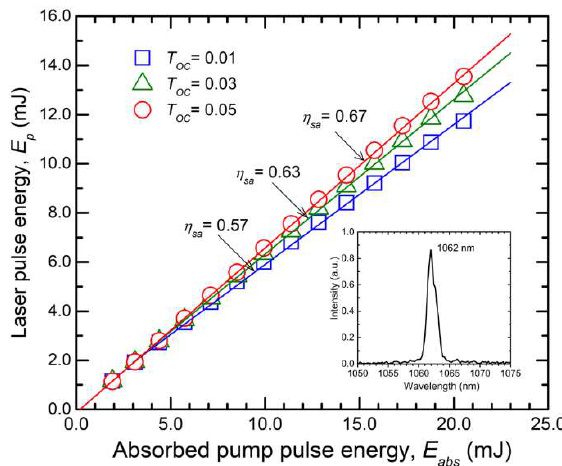
Figure 6. Laser pulse energy, E p , yielded by the c -cut Nd:LGSB crystal versus absorbed pump-pulse